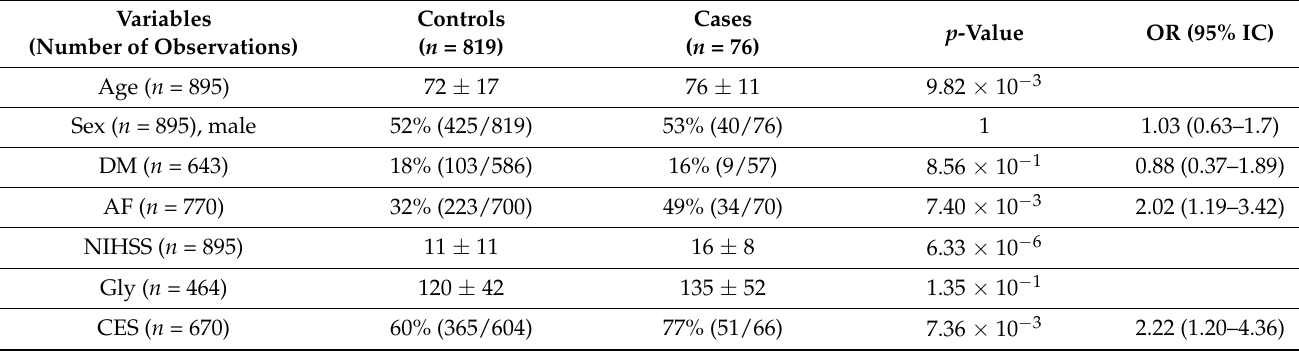
Table 4. Descriptive analysis of the replication